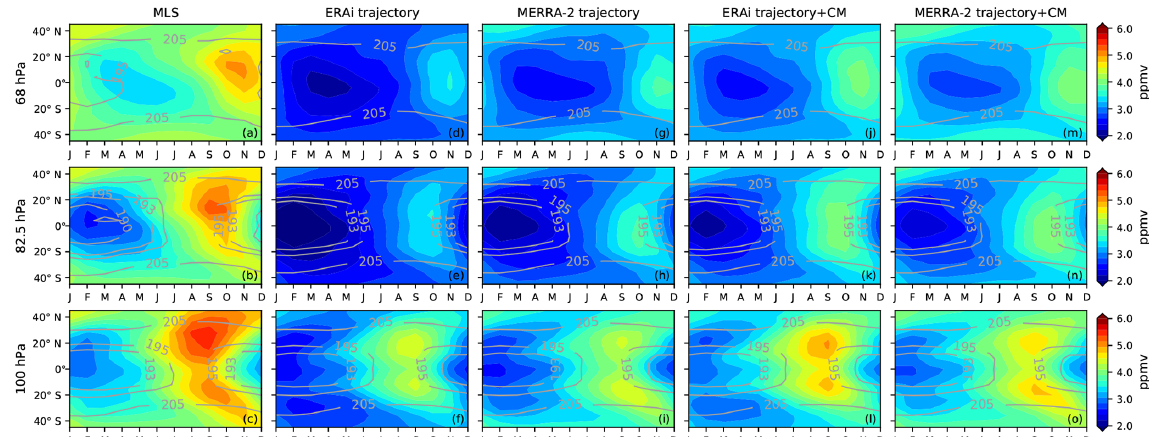
Figure 1. Zonal mean seasonal cycle of water vapor (ppmv, color shading) and temperature (K, contour lines) between 40 ◦ S and 40 ◦ N from the (a–c) MLS; (d–f) ERA-Interim (ERAi) trajectory model; (g–i) MERRA-2 trajectory model; (j–l) ERAi trajectory model with the cloud model; and (m–o) MERRA-2 trajectory model with the cloud model at 68hPa (top row), 82.5hPa (middle row), and 100hPa (bottom row).